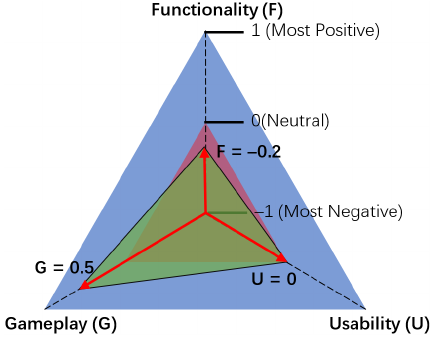
Figure 2. An example of playability triangular